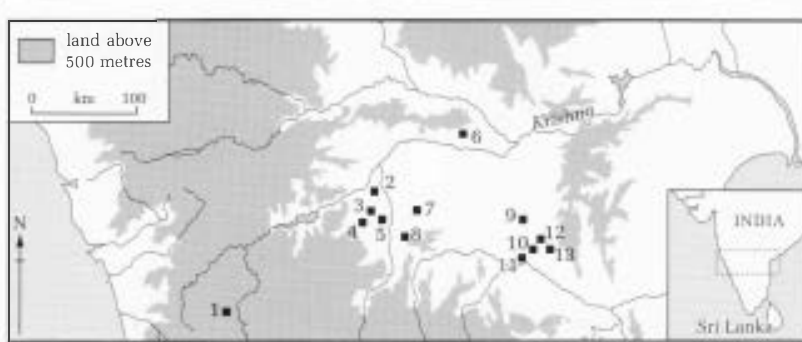
Figure 2 Neolithic sites in the states of Karnataka and Andhra Pradesh sampled for plant remains since 1 997. (1) Hallur, (2) Tekkalakota, (3) Kurugodu, (4)Kudatini, (5) San­ ganakallu and Hiregudda, (6) Utnur, (7) Hattibelagallu, (B) Velpumadugu, (9) Singan­ apalle, (10) Rupangudi, (11) Hanumantaraopeta, (12) Injedu, (13) Peddamudiyam.